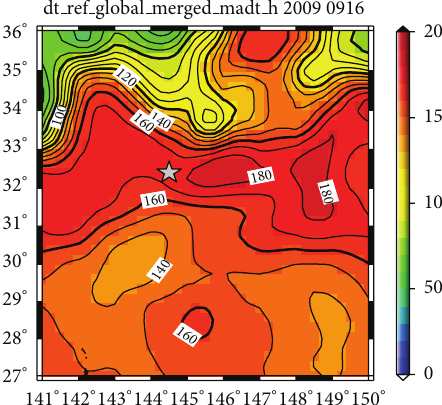
Figure 1: Horizontal distributions of sea surface height anomalies observed by satellite altimeter (http://www.aviso.oceanobs.com/) at 7-day intervals between September 2 and September 30, 2009, which includes the period of the passage of Typhoon Choi-wan. The maps were created by using the delayed time reference series product of weekly mean sea level height. The contour interval is 10cm. In each panel, the location of the KEO moored buoy is shown by the star. The track of Typhoon Choi-wan (from the Regional Specialized Regional Center (RSMC)—Tokyo best—track data set) is shown by black circles in two